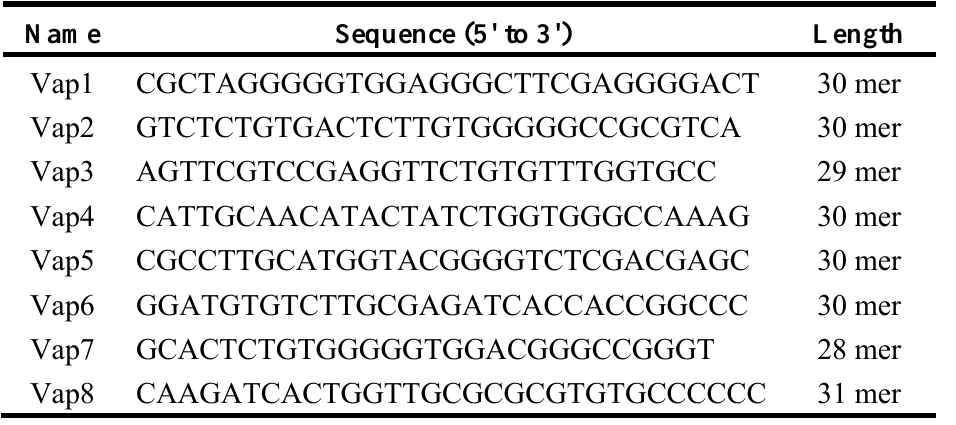
Table 1. Sequence obtained after three rounds of screening. The table shows only the random sequence region. All aptamers had a Fw primer sequence at the 5'-end and a complimentary Rev primer sequence at the 3'-end. (The sequences of the primer are given in the Methods section in the SELEX protocol subsection).